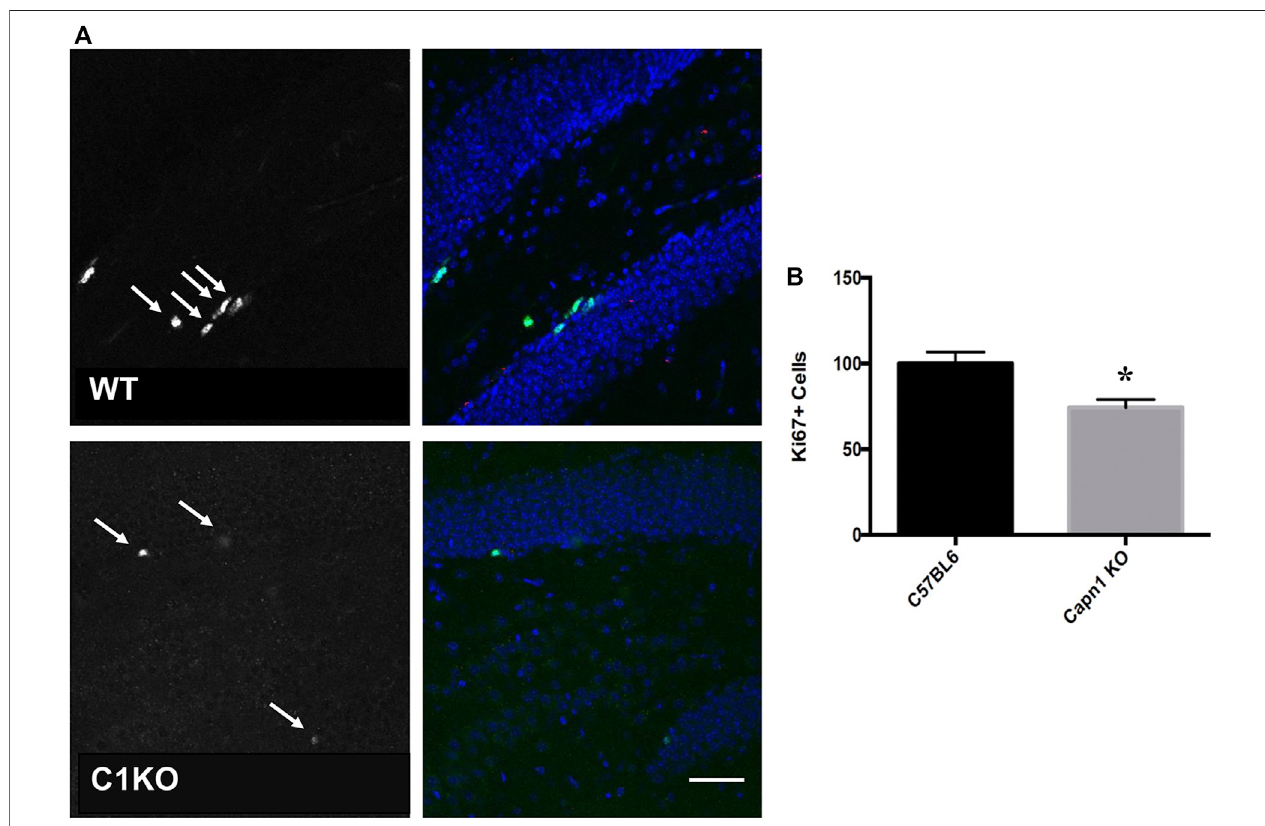
FIGURE2| Ki67+cellsinthedentate gyrusofWTand C1KOmice.Adjacentsections fromtheonesusedfortheBrdUanalysiswereusedforimmunolabeling with antibodies against Ki67 (A) , left panels, arrows) and NeuN (A) , right panels, green). Numbers of Ki67+ cells were quanti fi ed as indicated in the Materials and Methods section (B) .SectionswerecounterstainedwithDAPI(blue).Fivesectionspermousewerequanti fi edand5WTandC1KOmicewereanalyzed.Resultsareexpressedas percent of the average number of cells in the WT mice and are Means ± SEM of 5 mice per group. * p < 0.01, Student ’ s t-test. Scale bar: 50